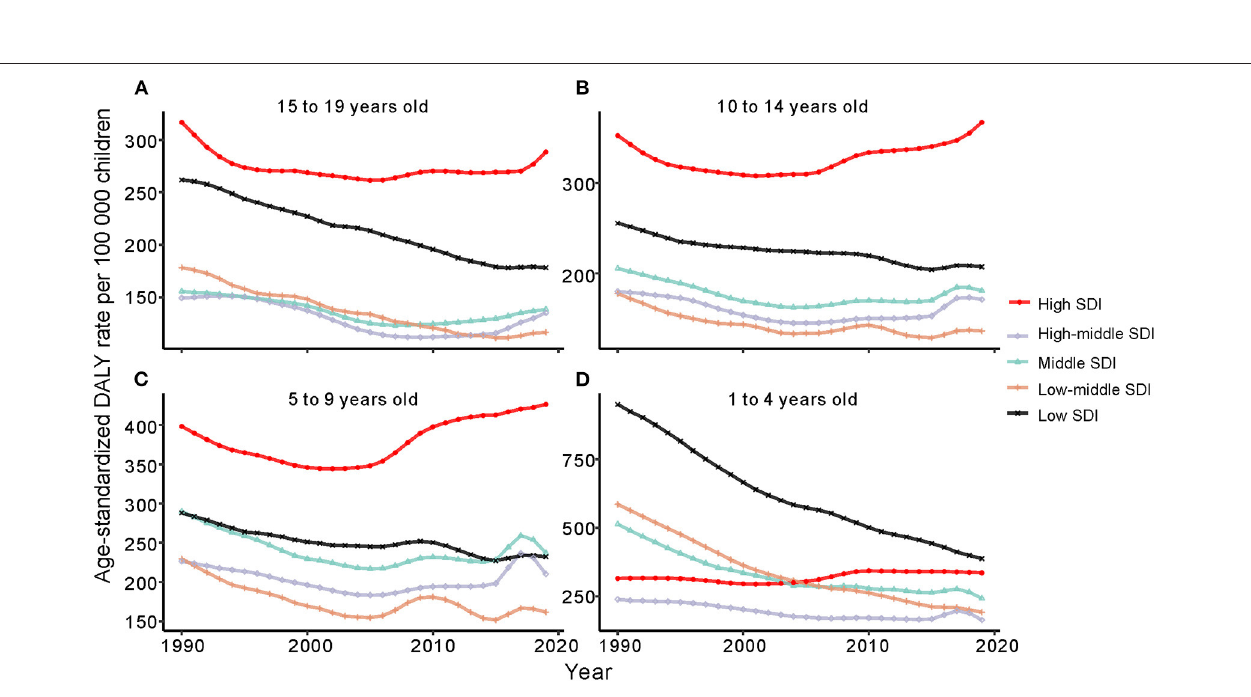
Frontiers in Pediatrics |